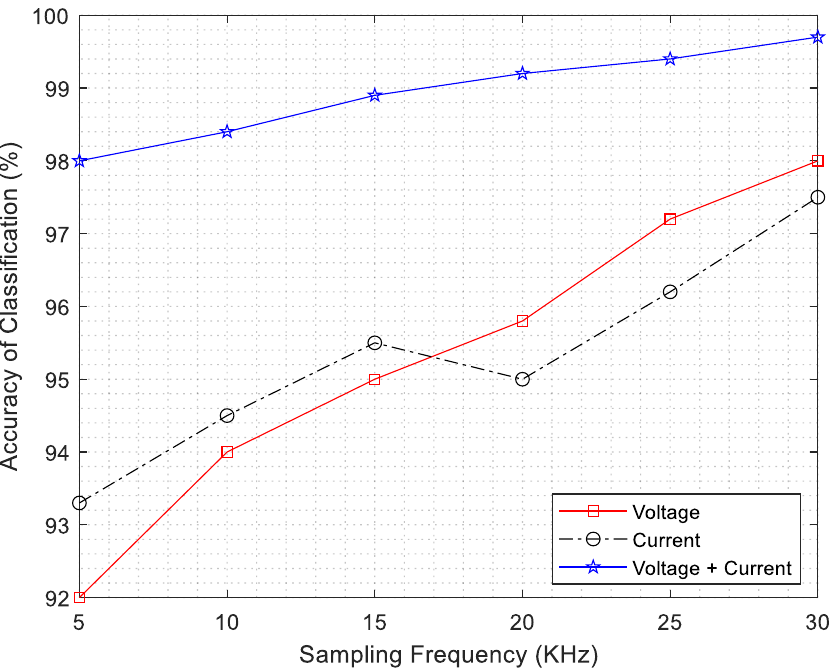
Figure 8. The percentage of the classification accuracy of the proposed method.